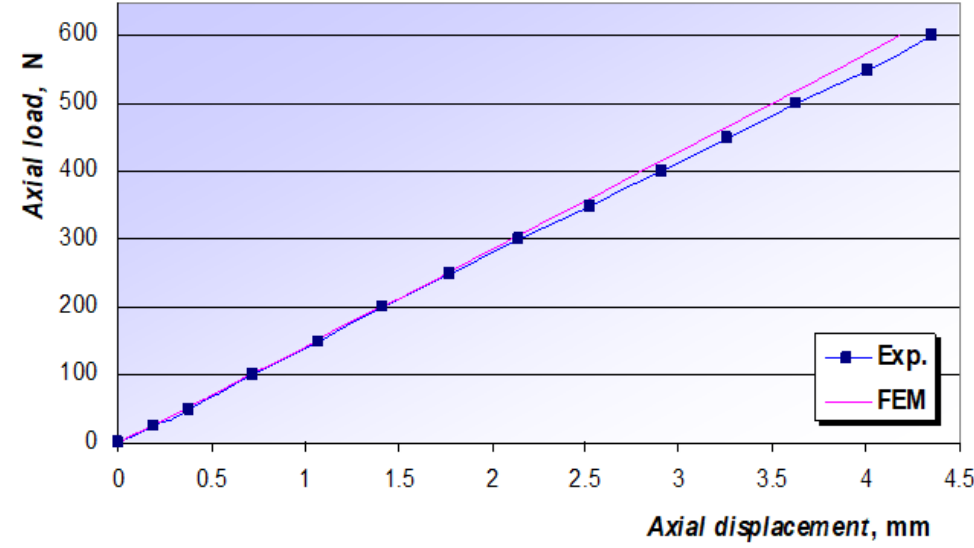
Figure 11. Comparative diagram of the axial displacement d at the point of load.